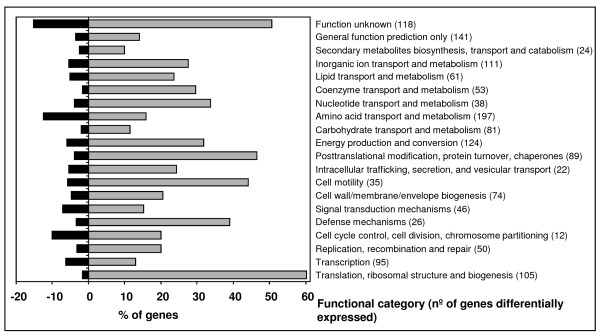
Distribution of genes with differentially altered expression into COGs. Effect of the tolC gene mutation on the S. meliloti transcriptome analyzed according to the distribution of the genes with altered expression into 20 functional categories (COGs) as predicted using NCBI database. The black and grey bars represent the percentage of genes in each functional category whose transcription was decreased and increased, respectively, in the tolC mutant SmLM030-2 by comparison to the wild-type strain 1021.